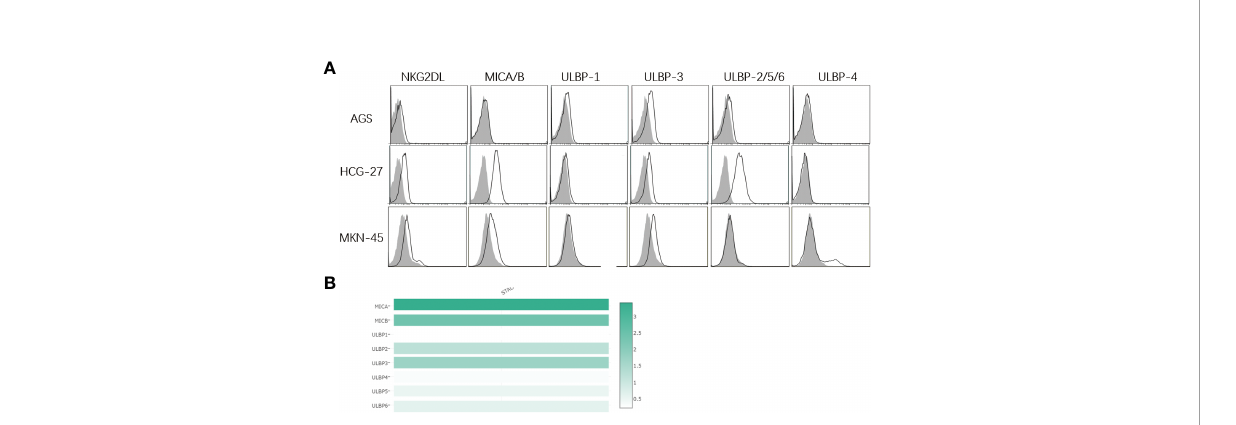
FIGURE 1 Expression of NKG2D ligands on surface of human gastric cancer cell lines. (A) Flow cytometry detects the expression of NKG2D ligands in human gastric cancer cell lines. The white histogram indicates expression of NKG2D-Fc, MICA/B, ULBP-1, ULBP-3, ULBP-2/5/6 and ULBP-4, and the shadow histogram indicates the expression of the matched isotype control. MICA/B is highly expressed in HCG-27 and MKN-45 cells, and moderate ULBP3 expression is detected in AGS, HCG-27 and MKN-45 cells, while low ULBP1/4 expression is found in AGS, HCG-27 and MKN-45 cells; (B) NKG2D ligand expression is analyzed in stomach adenocarcinoma in the Gepia server, and the highest MICA expression (score 3.4) is seen, followed by MICB expression (score 2.4), ULBP3 expression (score 1.7), ULBP2 (score 1.2), ULBP6 (score 0.6), ULBP5 (score 0.5), ULBP4 (score 0.3) and ULBP1 (score 0.2), which is almost in agreement with the expression of NKG2D ligands in human gastric cancer cell